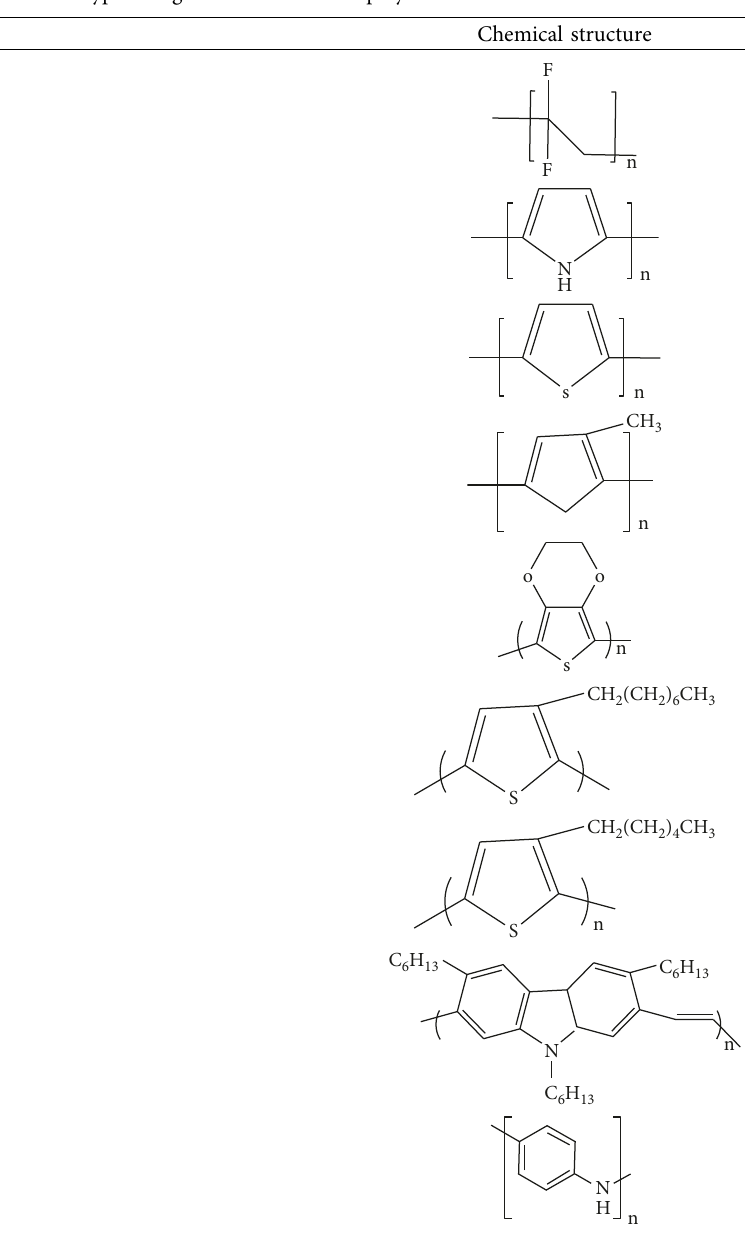
Table 2: Chemical structure of typical organic thermoelectric